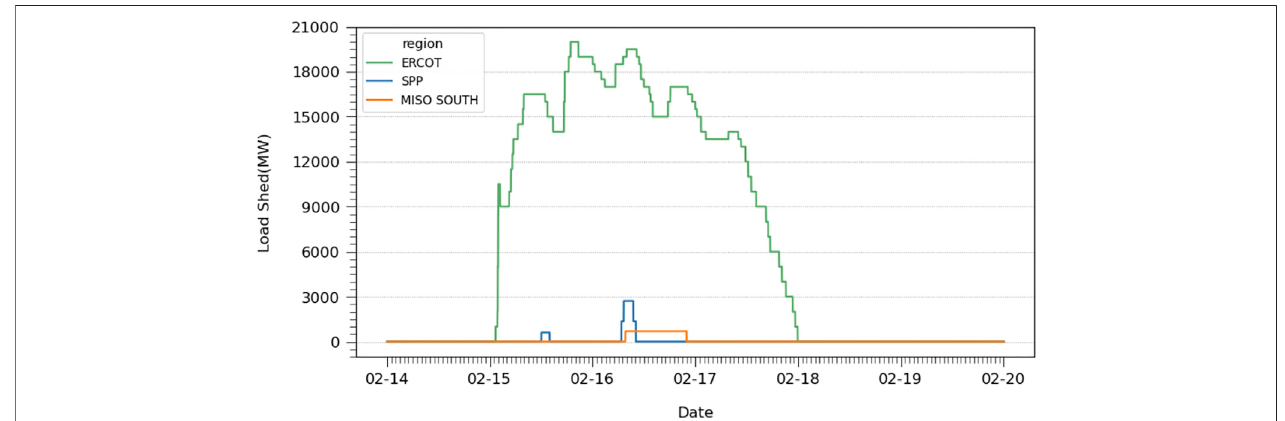
FIGURE 4 | Load shed in ERCOT, SPP, and MISO South during the